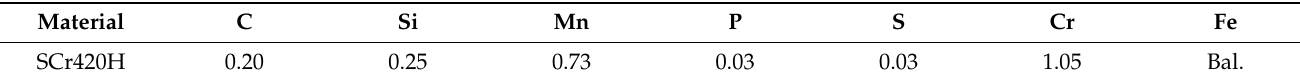
Table 1. Chemical composition of